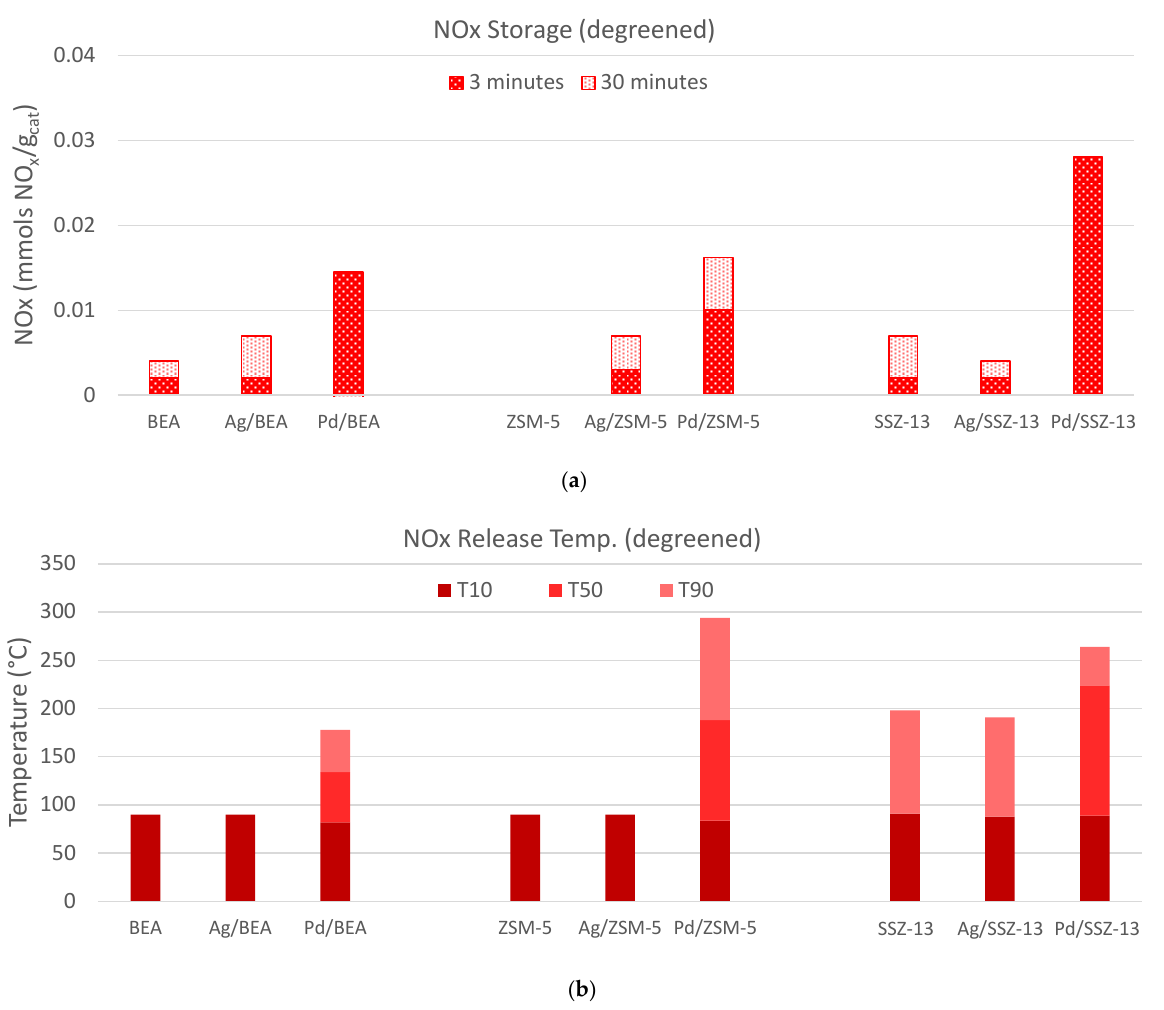
Figure 4. ( a ) NOx concentration for each of the three reactor evaluations throughout the 60 min experiment. ( b ) NOx adsorption after 3 ( ) and 30 ( ) minutes for Pd ZSM-5, and ( c ) the temperature where 10% (T10, ■ ), 50% (T50, ■ ), or 90% (T90, ■ ) of the NOx is released for PD/ZSM-5.